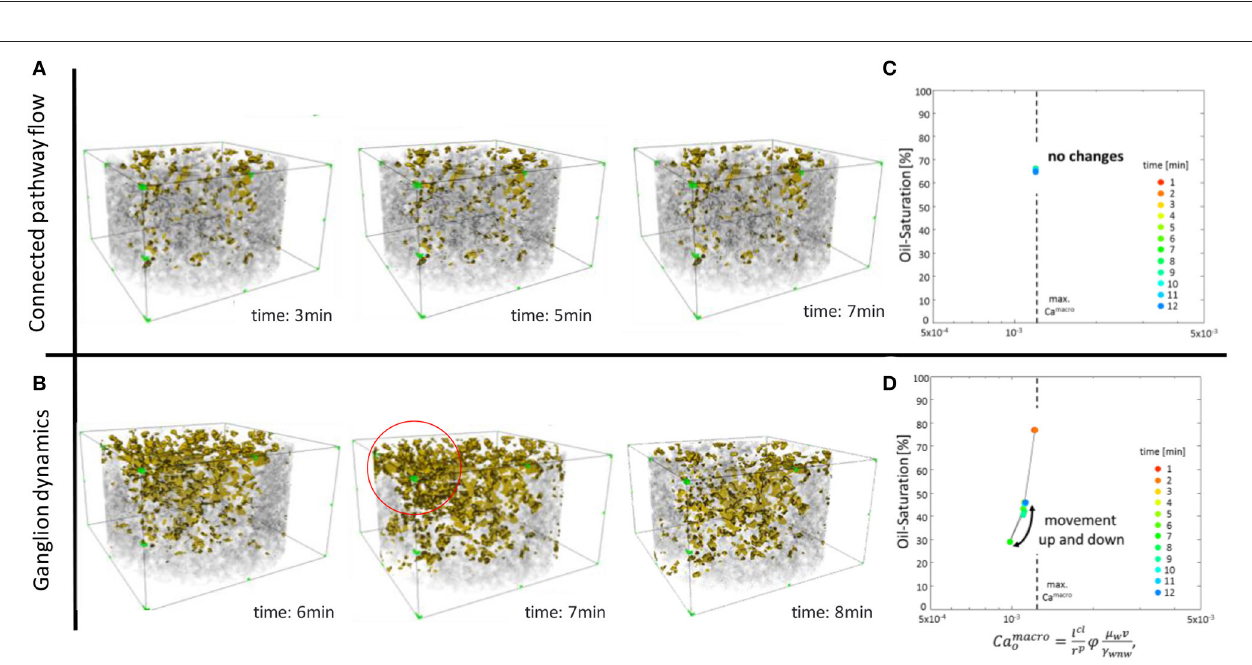
FIGURE 13 | Fractional flows f w (0.8, 0.5, and 0.2) and cluster-based capillary number Ca cluster from Equation (7) for the micro-CT flow experiments conducted at flow rates of 3, 30, and 300 µ l/min (A) . For all flow rates and fractional flows Ca cluster ≪ 1, which means that the flow regime is capillary dominated. The bounding line for Ca macro = 1, which is the transition to the viscous-dominated regime is plotted as red line in (B) in the flow velocity (left axis) and injection rate (right axis) vs. cluster length (C) space. Also, the largest cluster falls below this line even at the highest flow rate, which means that the flow regime is capillary dominated.